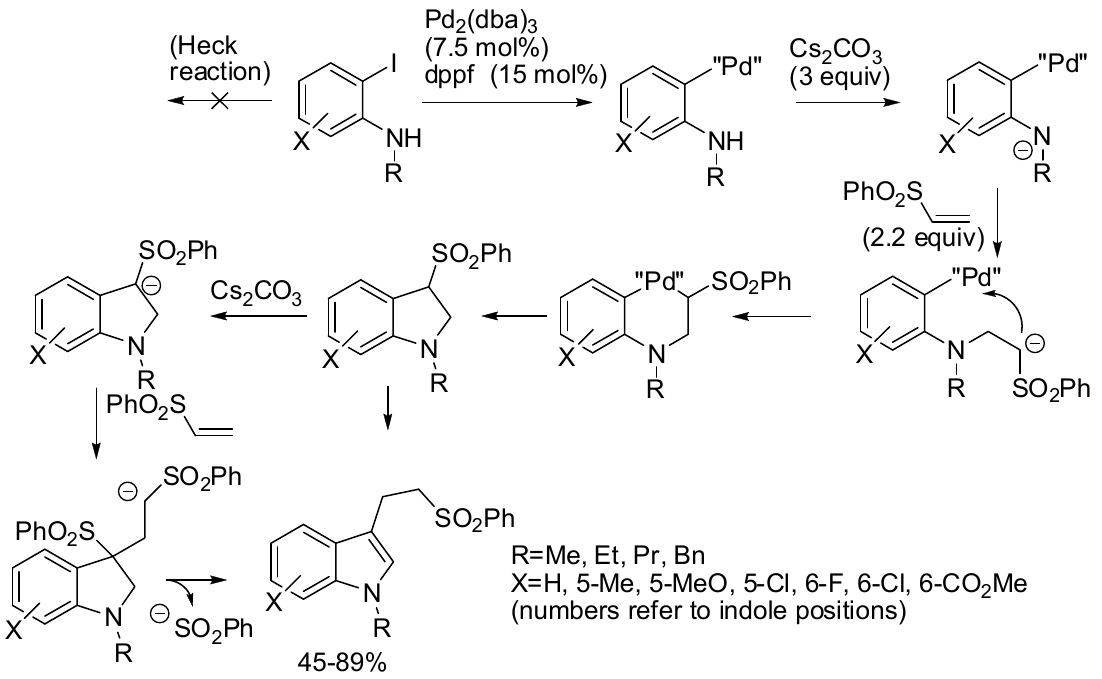
Scheme 29. Three-component synthesis of